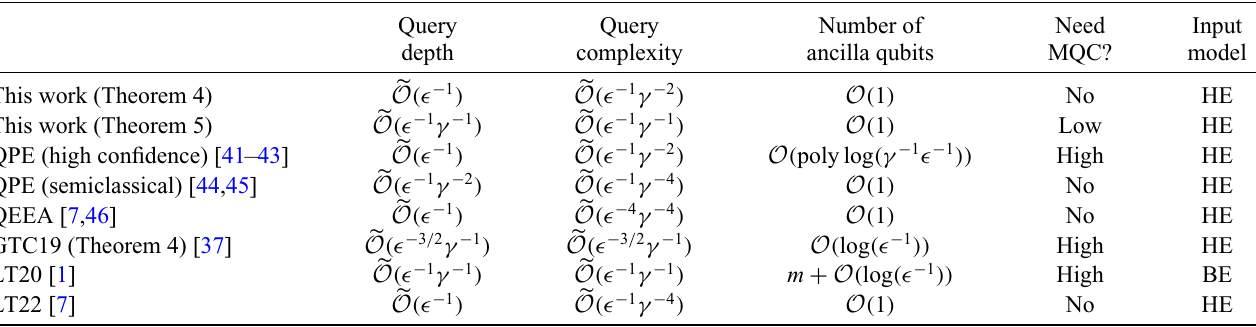
TABLE I. A comparison of the performance of quantum algorithms for ground-state energy estimation in terms of the query complexity, the query depth, the number of ancilla qubits, and the level of multiqubit control (abbreviated as “MQC” in the table) operations needed. γ is the overlap between the initial guess | φ 0 (cid:3) and the ground state and (cid:4) is the allowed error. “HE” denotes the Hamiltonian-evolution model (assuming no ancilla qubits) and “BE” for the block-encoding model. The sharper estimate for estimat- ing the ground-state energy using the quantum-eigenvalue-estimation algorithm (QEEA) is given in Ref. [7, Appendix C]. We assume that Ref. [1] uses m ancilla qubits and that the high-level MQC operation is due to the block encoding of H . Query Query Number of Need Input depth complexity ancilla qubits MQC? model